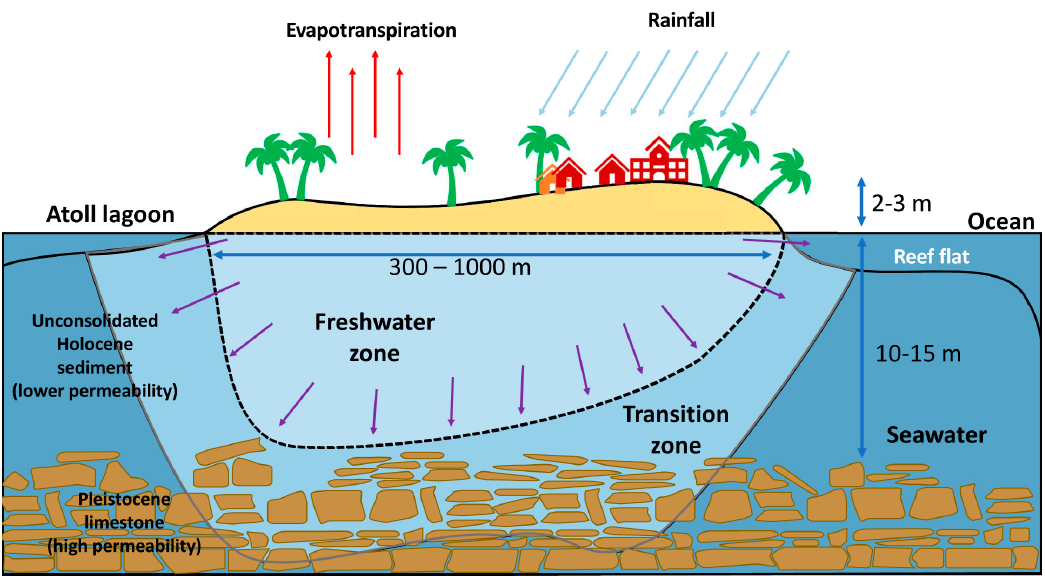
Figure 1. A conceptual image of a typical aquifer of the islands, adapted from Terry et al. [22]. The vertical scale is highly